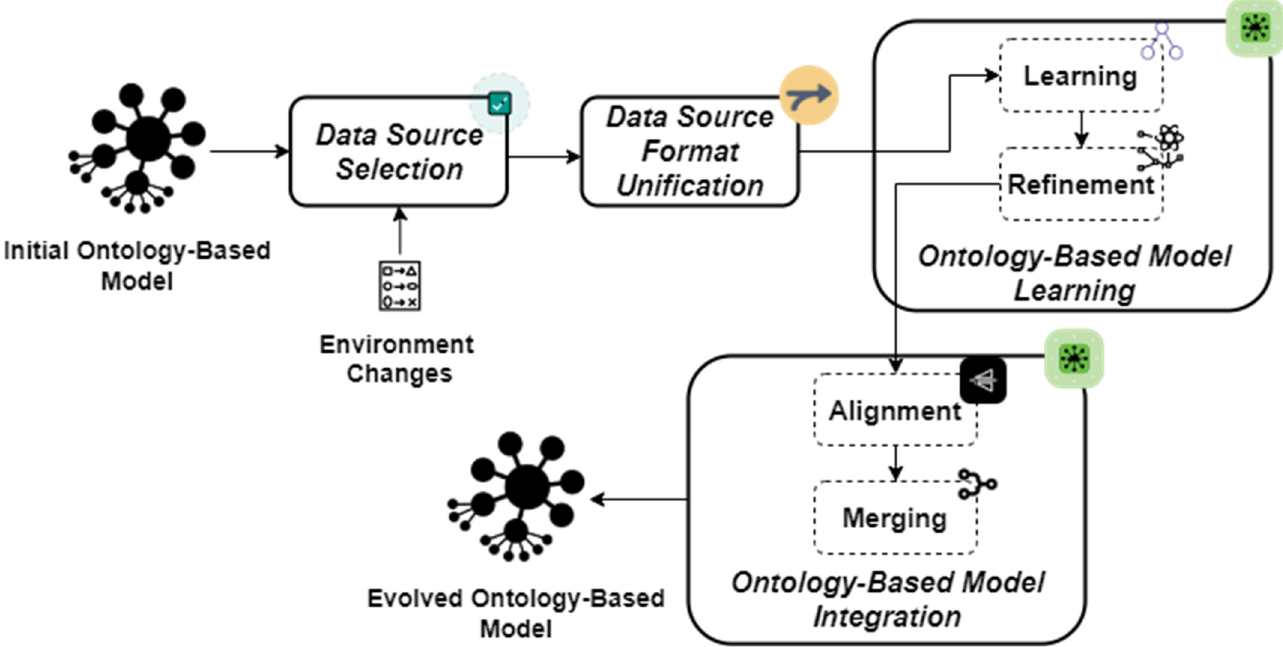
Figure 1. Ontology-based model evolution approach.